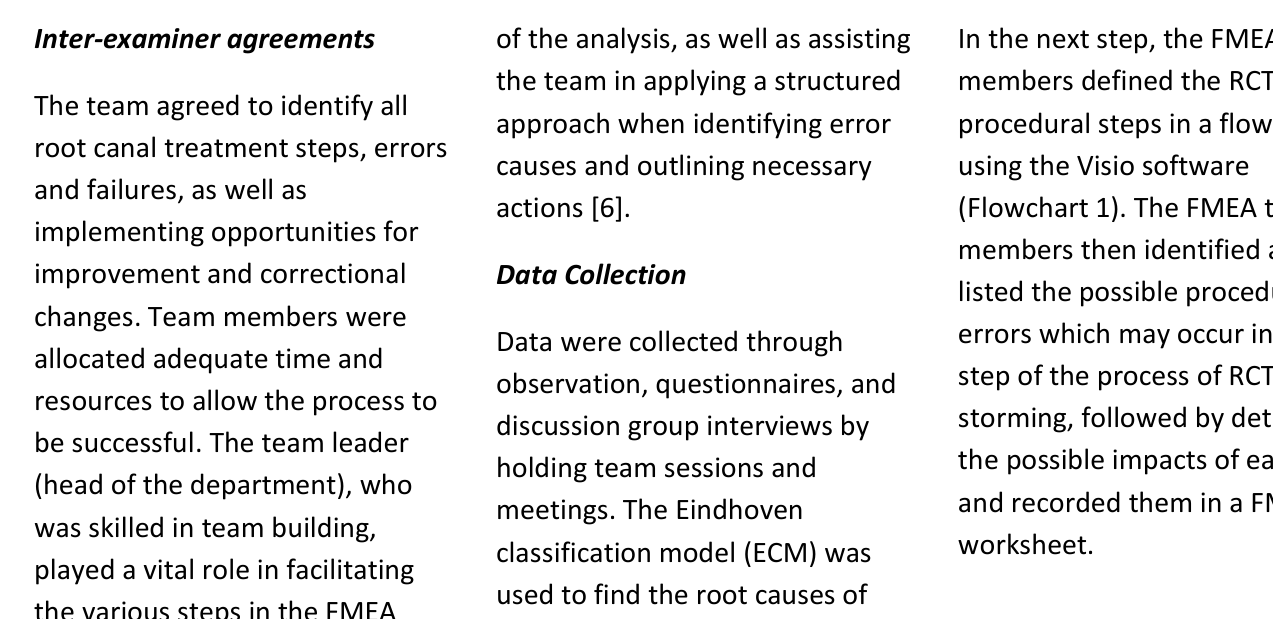
Quality control